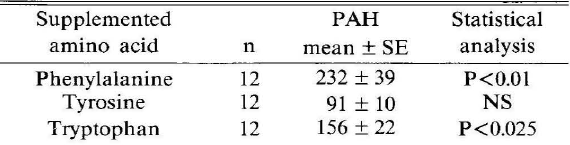
Table 1. PAH concentration. Relative amounts (PAH in supplemented medium/PAH in control medium X 100). SE standard error of mean.